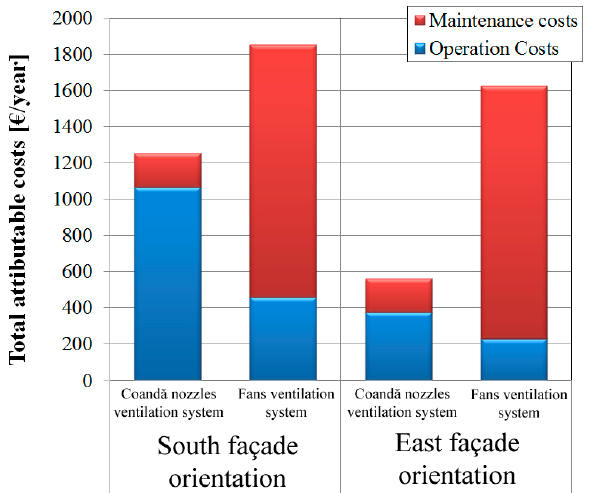
Figure 9. Total attributable costs of both ventilation systems for different façade orientations.